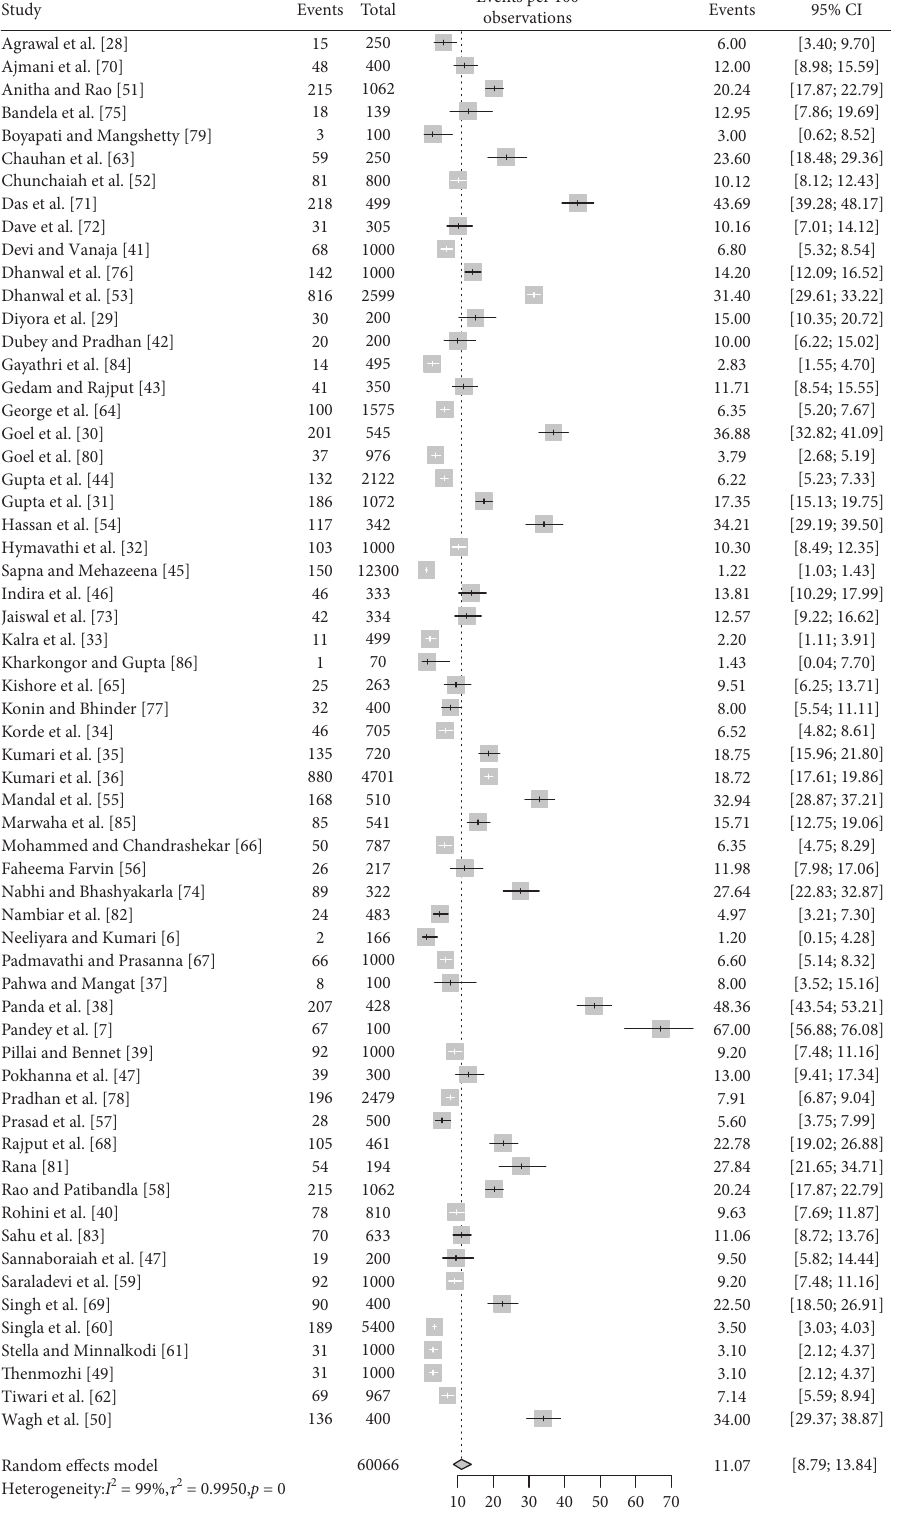
Figure 2: Forest plot showing pooled estimate for prevalence of overall